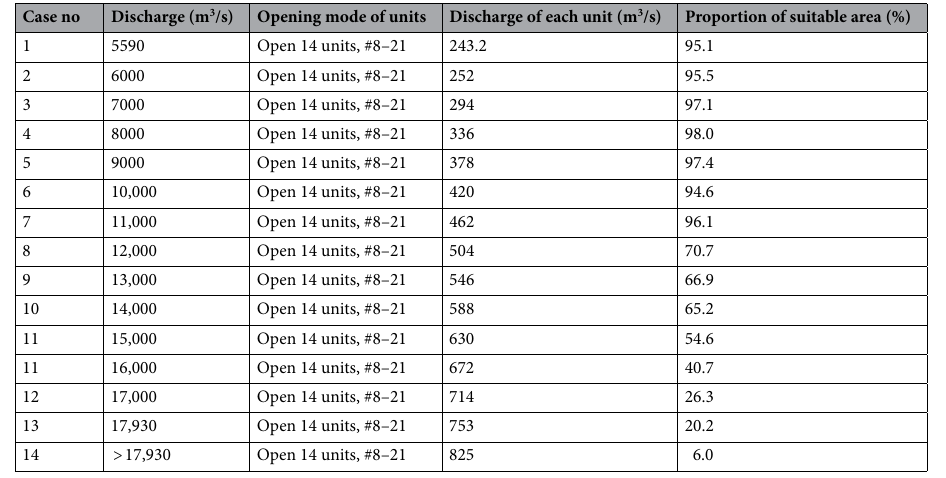
Table 2. Calculation cases with the same opening mode under different